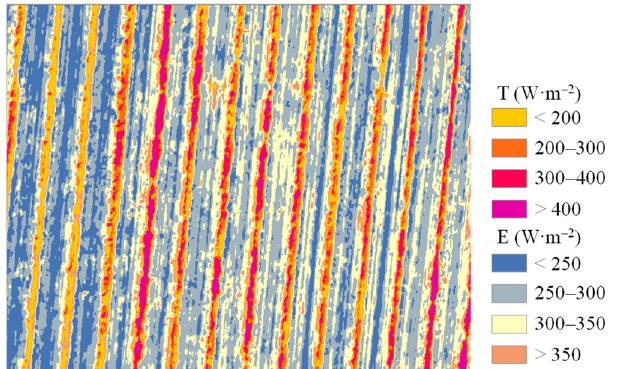
rate over a vineyard using UAV imagery and meteorological data on 16 July